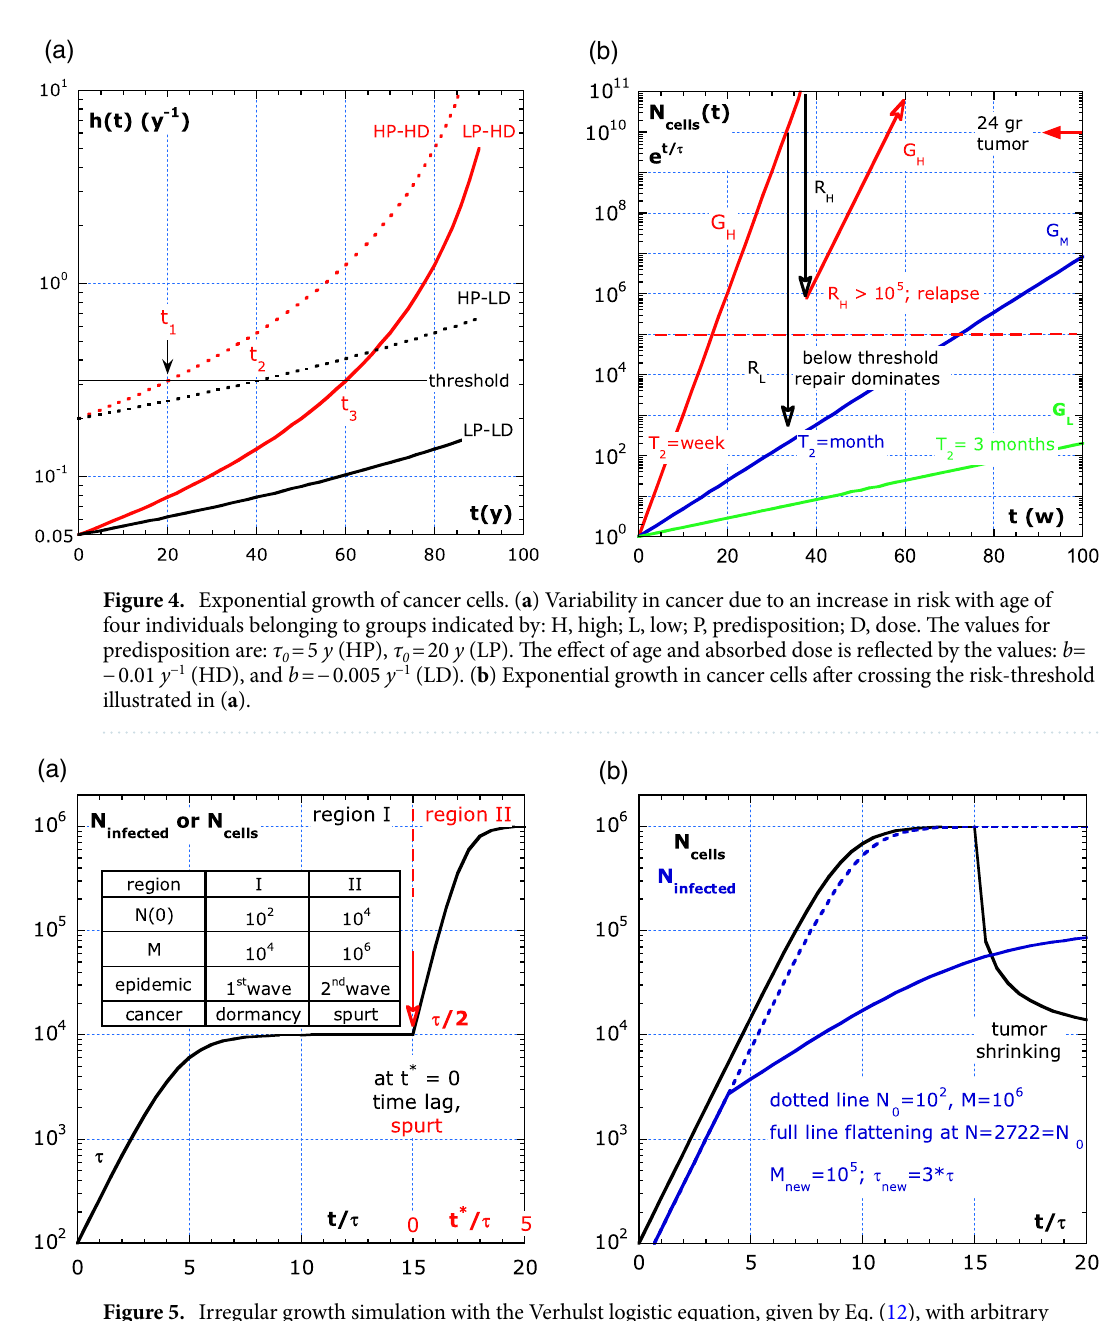
Figure 5. Irregular growth simulation with the Verhulst logistic equation, given by Eq. (12), with arbitrary parameters. ( a ) A sudden increase in risk results in a second wave in pandemics and a growth spurt in cancer. ( b ) A reduction of risk for growth can result in flattening the curve in pandemics or the tumor shrink by e.g., radiotherapy for